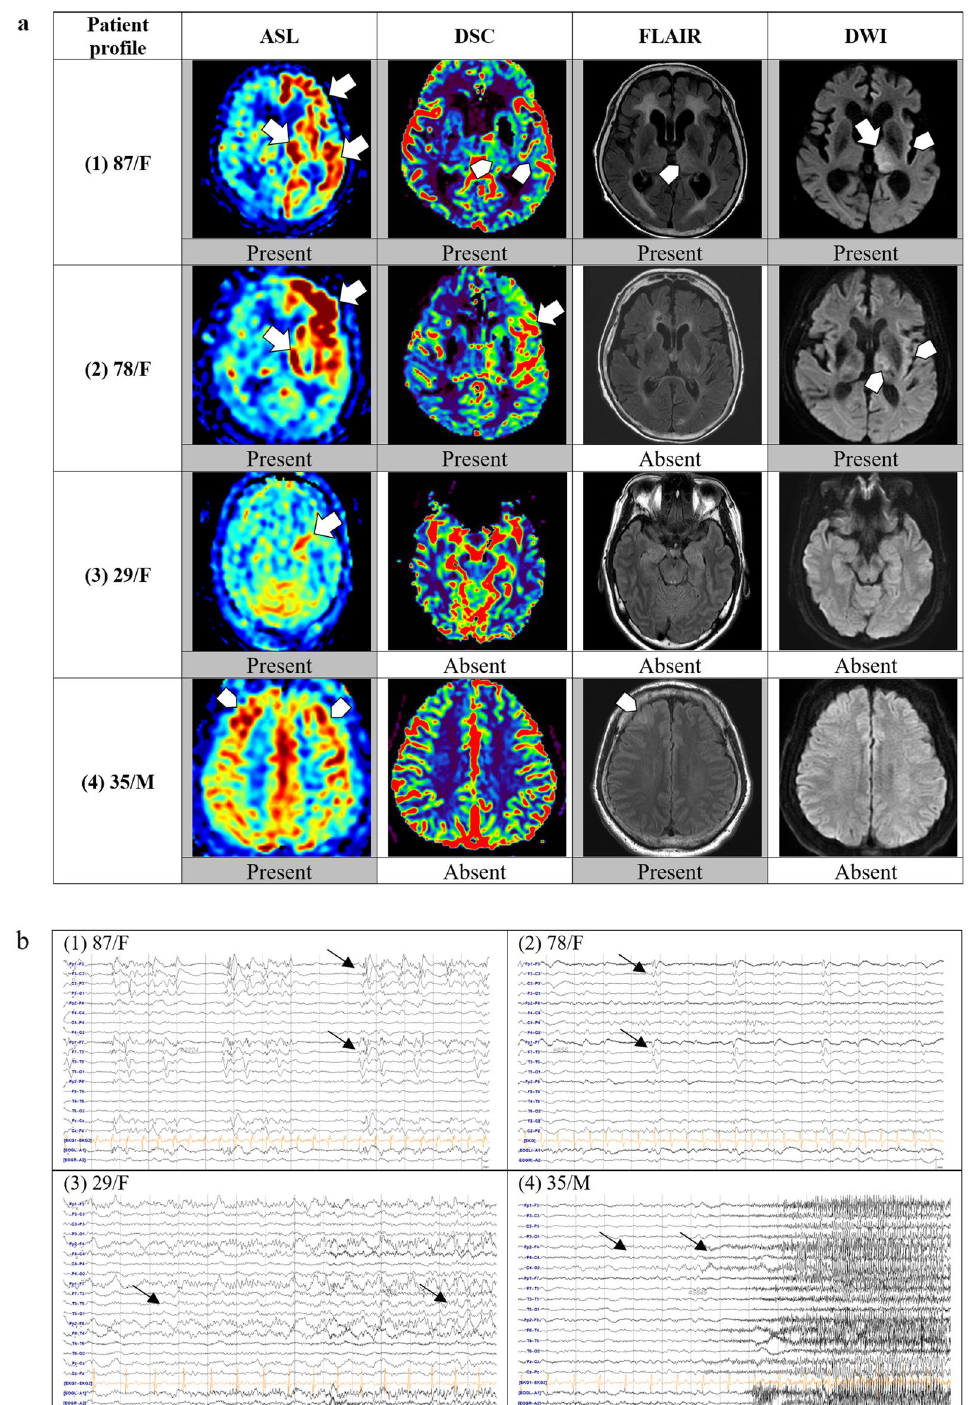
Figure 2. Examples of brain MRI sequences and EEGs of four representative patients with status epilepticus. Brain MRI and EEG of each patient were listed according to the same number from (1) to (4). ( a ) Brain MRI: (1) ASL showing hyperperfusion in the left frontal and temporal cortices and the left thalamus. DSC reveals subtle increases in perfusion in the left thalamus and lateral temporal lobe. FLAIR and DWI show changes in the left thalamus and insula. (2) ASL and DSC show definite hyperperfusion in the left frontal and temporal lobes, FLAIR shows no changes, and DWI shows subtle restrictions in the left thalamus and insula. (3) ASL shows definite hyperperfusion in the left hippocampus, but no signal changes are noted on DSC, FLAIR, or DWI. (4) ASL showing subtle hyperperfusion in the bilateral frontal cortices, and subtle T2 hyperintensity is noted in the left frontal cortex. ( b ) EEG: (1) Left frontotemporal periodic discharges. (2) Left frontotemporal periodic discharges. (3) Left temporal rhythmic delta activity with evolution indicating an electrographic seizure. (4) Right frontal theta rhythm evolving to beta activity, indicating an electrographic seizure. ASL arterial spin labeling; DSC, dynamic susceptibility contrast, DWI diffusion-weighted imaging, EEG electroencephalogram, FLAIR fluid-attenuated inversion recovery, MRI magnetic resonance